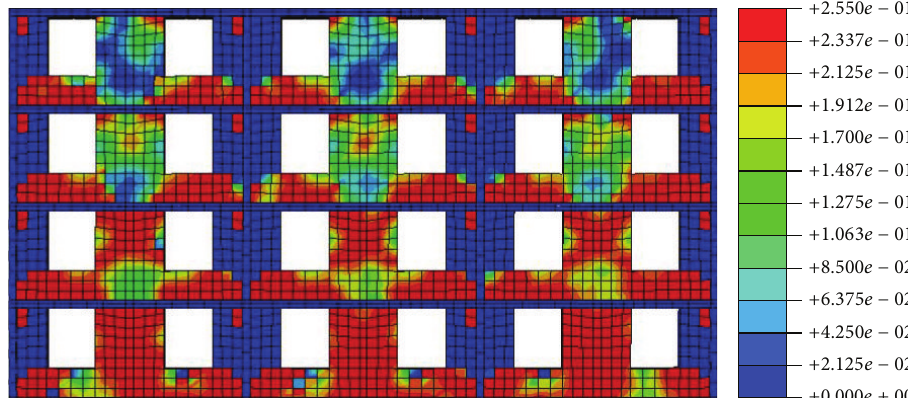
Figure 32: Tension crack damage cloud of model 1 under Wolong ground motion.